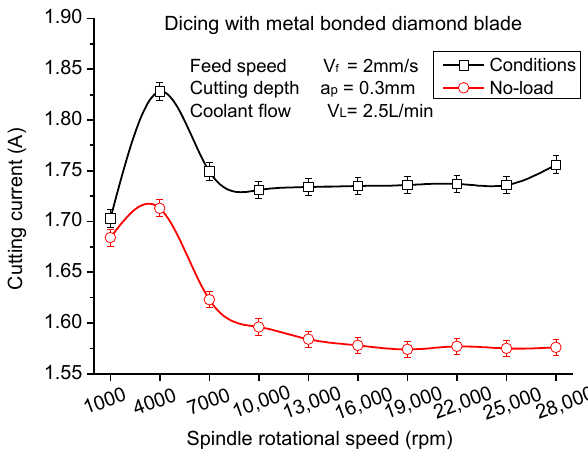
Figure 5. Maximum cutting current varying with spindle rotational speed.